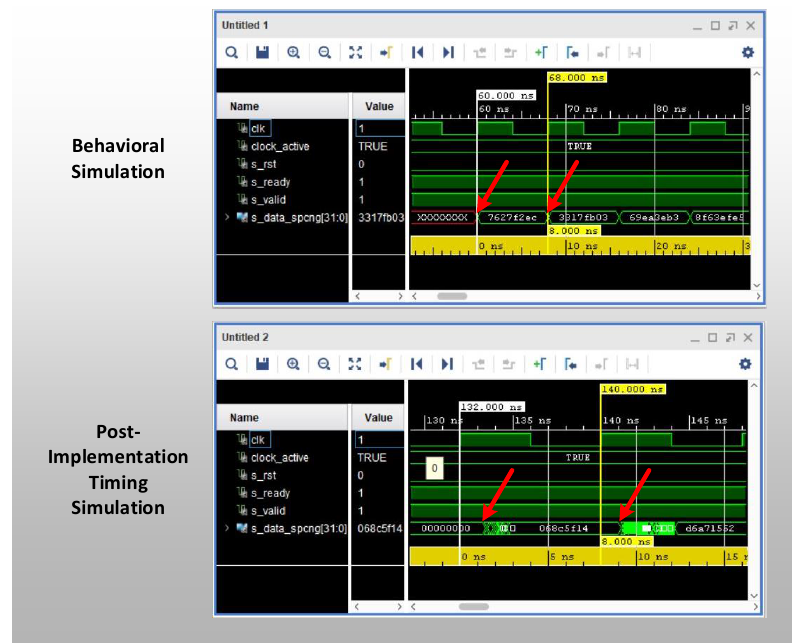
Figure 6. Behavioral simulation and Post-implementation timing